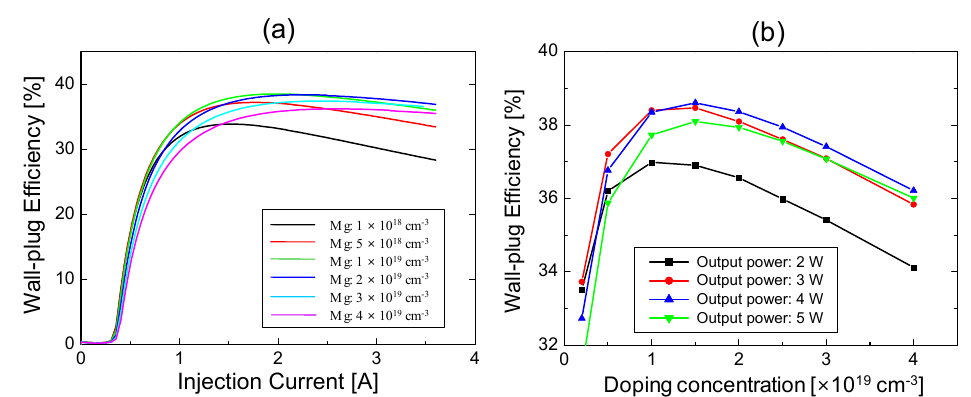
Figure 10. ( a ) WPE as a function of injection current for various Mg doping concentrations in the p-AlGaN cladding layer. ( b ) WPE as a function of Mg doping concentration in the p-AlGaN cladding layer for the output power of 2, 3, 4, and 5 W.